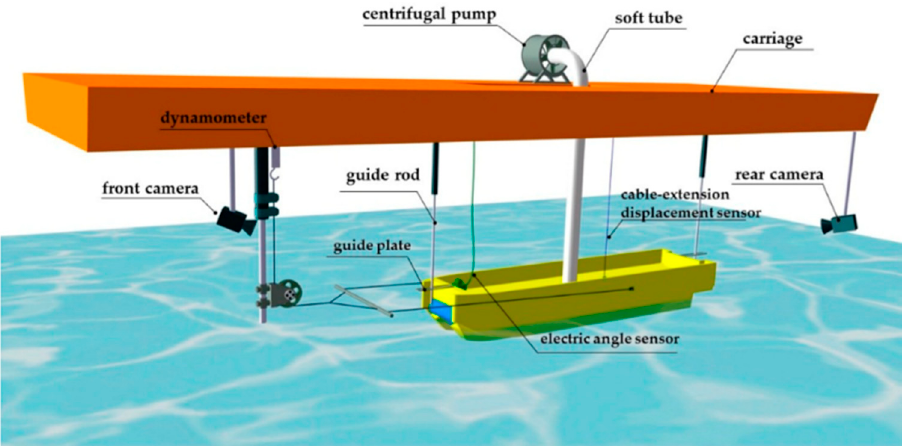
Figure 3. View of the experimental setup.